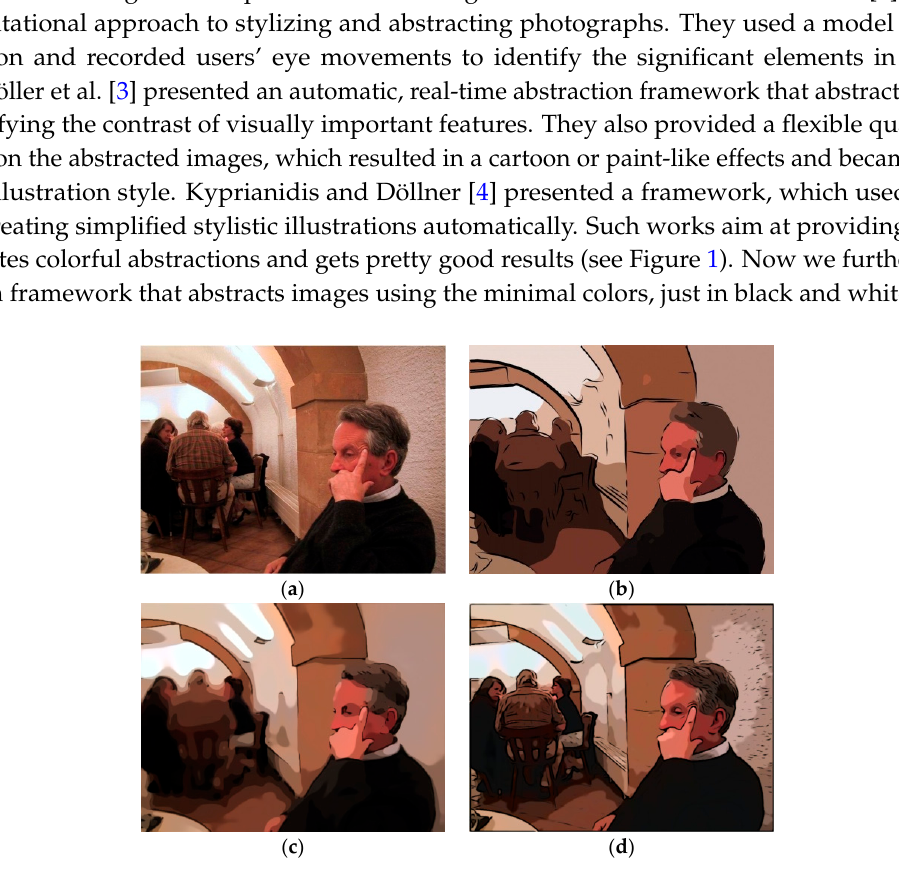
Figure 1. Image abstraction. ( a ) input ( b ) DeCarlo and Santella [2] ( c ) Winnemöller, et al. [3] ( d ) Kyprianidis and Döllner. [4]